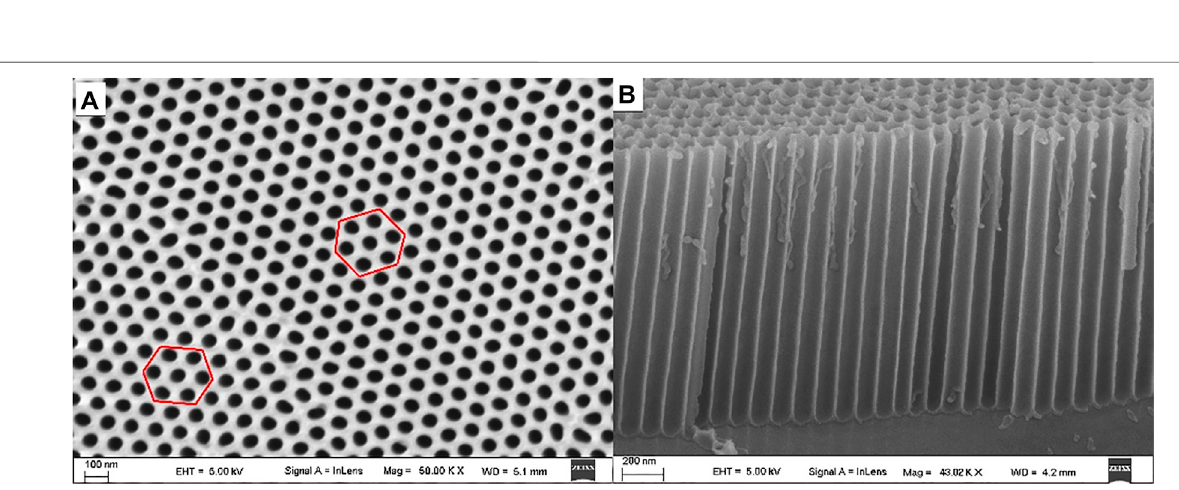
Frontiers in Physics |